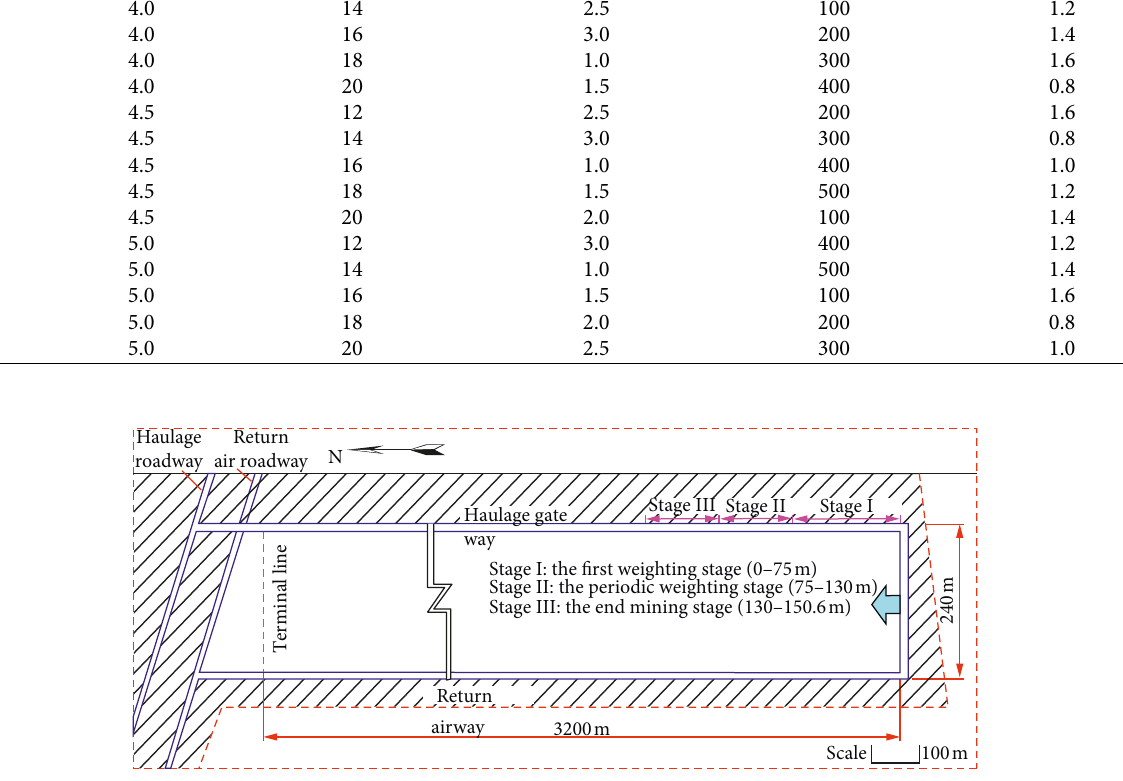
Figure 2: The schematic diagram of the 23103 working